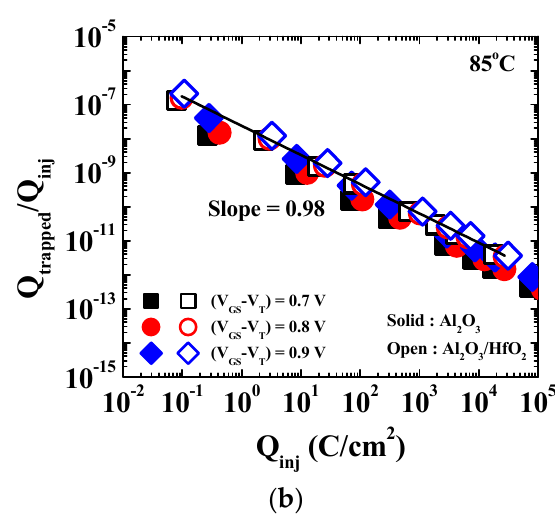
Figure 4. ( a ) Δ V T degradation as a function of the injected charge for an In 0.7 Ga 0.3 As quantum-well (QW) MOSFETs with single-layer Al 2 O 3 and bi-layer Al 2 O 3 /HfO 2 gate stacks under PBT stress conditions and ( b ) the Q trapped /Q inj ratio as a function of the injected charge for both gate stacks.